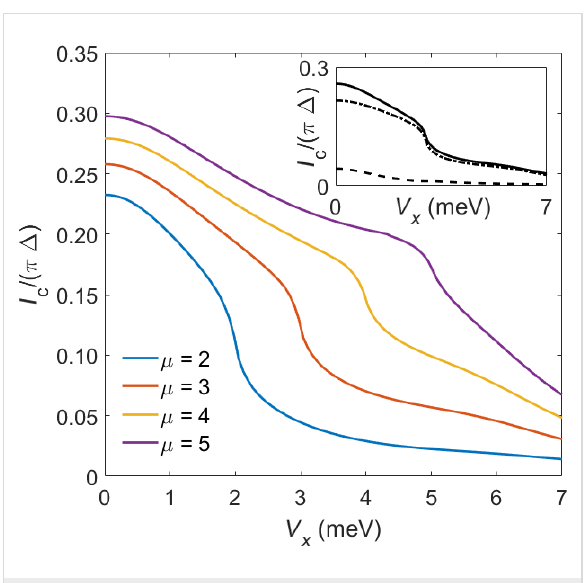
Figure 8: Main panel: Critical current I c vs Zeeman energy V x for S–QD–TS junctions from mean-field theory using the spinful TS nano- wire model (Equation 34). Results are shown for several values of the chemical potential μ (in meV), where we assume U = 10 Δ , ε 0 = − U /2, Δ p = Δ = 0.2 meV, Γ S = 2 Γ TS = 9 Δ , and B = ( V x ,0,0). Inset: Detailed view of the transition region V x ≈ for μ = 4 meV, including a decom- position of I c into the ABS (dotted-dashed) and the continuum (dashed) contribution.